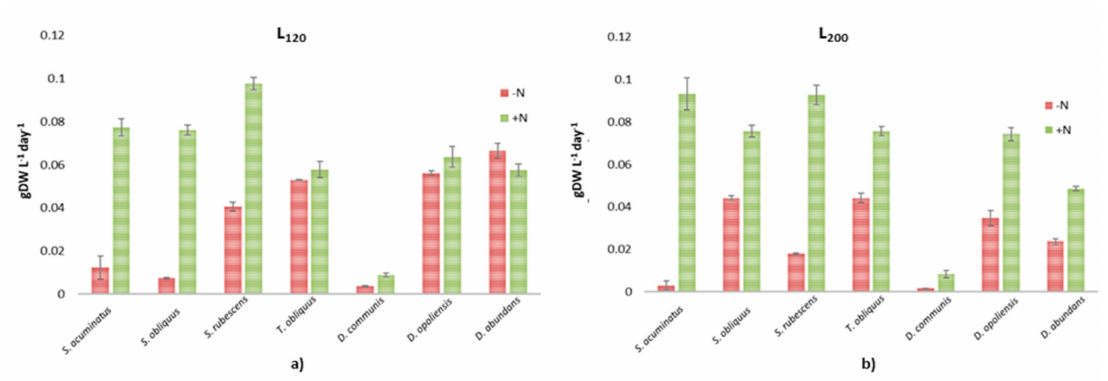
Figure 2. Biomass productivity, as grams of dry weight for liters for day, obtained for the seven strains grown at ( a ) 120 ± 20 µ mol photons m − 2 s − 1 (L 120 ) and ( b ) 200 ± 20 µ mol photons m − 2 s − 1 (L 200 ) with ( + N) and without ( − N) a nitrogen